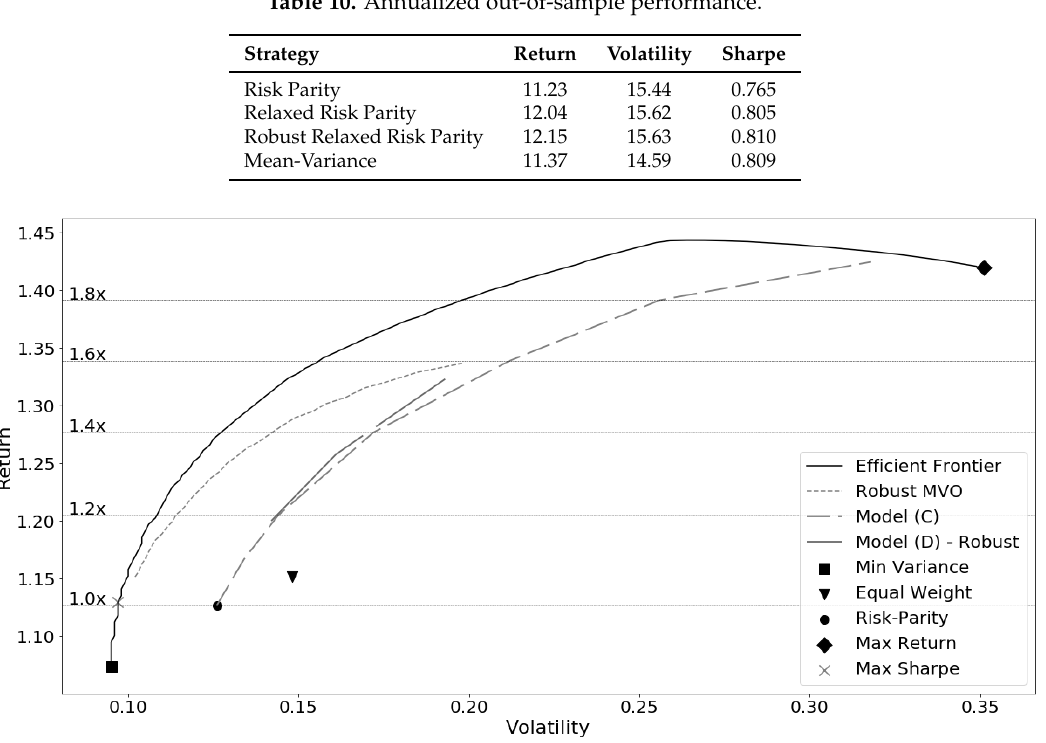
Figure 14. In-sample efficient